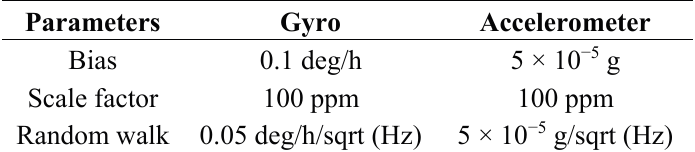
Table 3. Tactical grade IMU technical data.